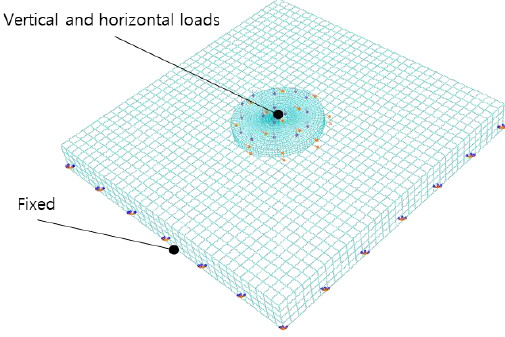
Figure 9. Interactions and load conditions in FEA model.